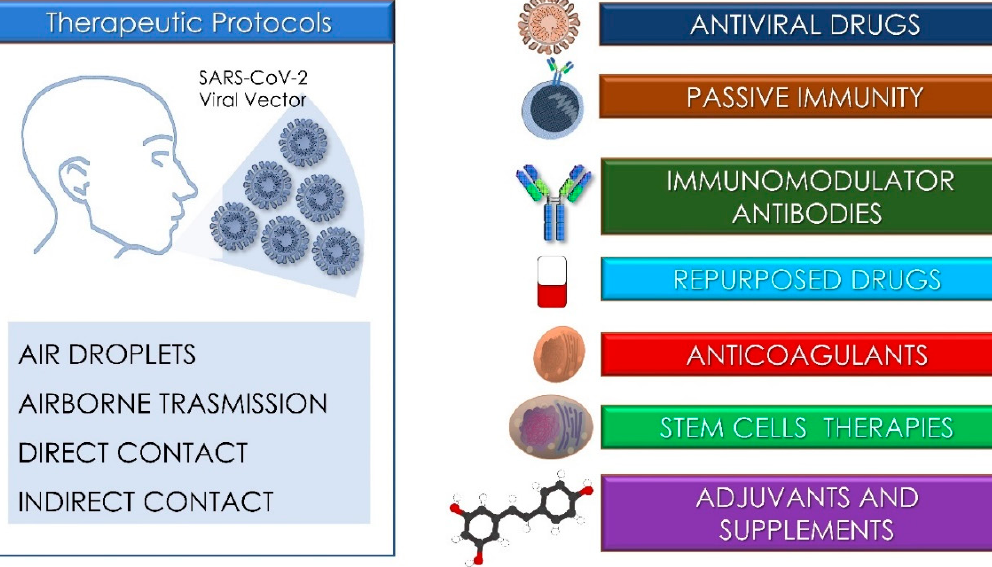
Figure 1. PRISMA flowchart summary of the manuscripts and scientific contribution selection [50].